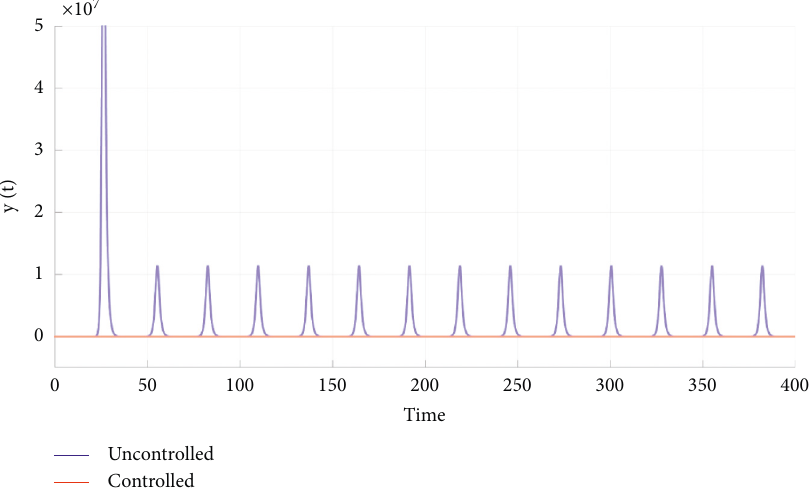
Figure 5: Comparison of controlled and uncontrolled infected cell populations.